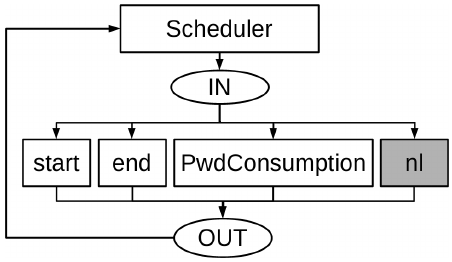
Figure 8. Consumption Simplified Model of the application.